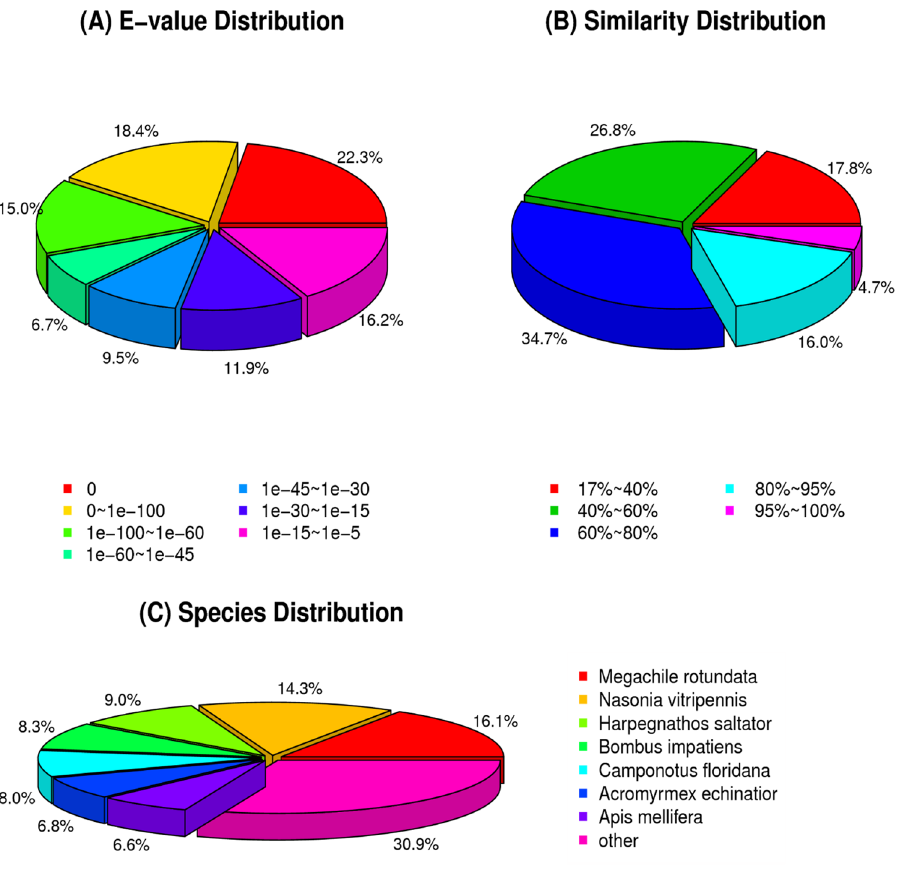
Figure 1. Homology analyses results. The BLASTx annotations of Aphidius gifuensis antenna transcripts ( A ) E-value distribution, ( B ) Similarity distribution, and ( C ) Species distribution.